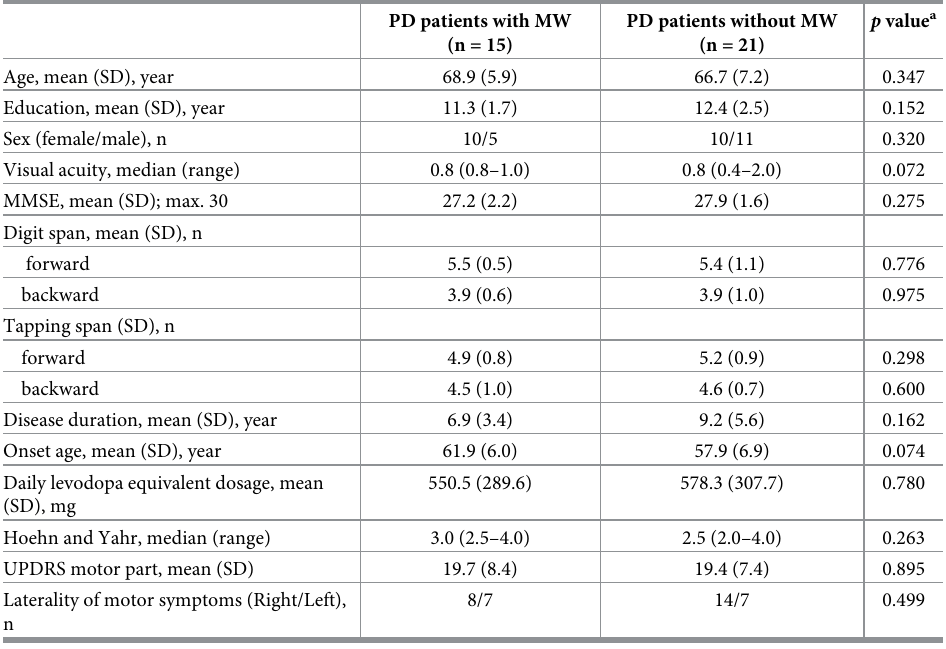
Table 2. Demographic and clinical characteristics of the PD patients with mirror writing and PD patients without mirror writing.